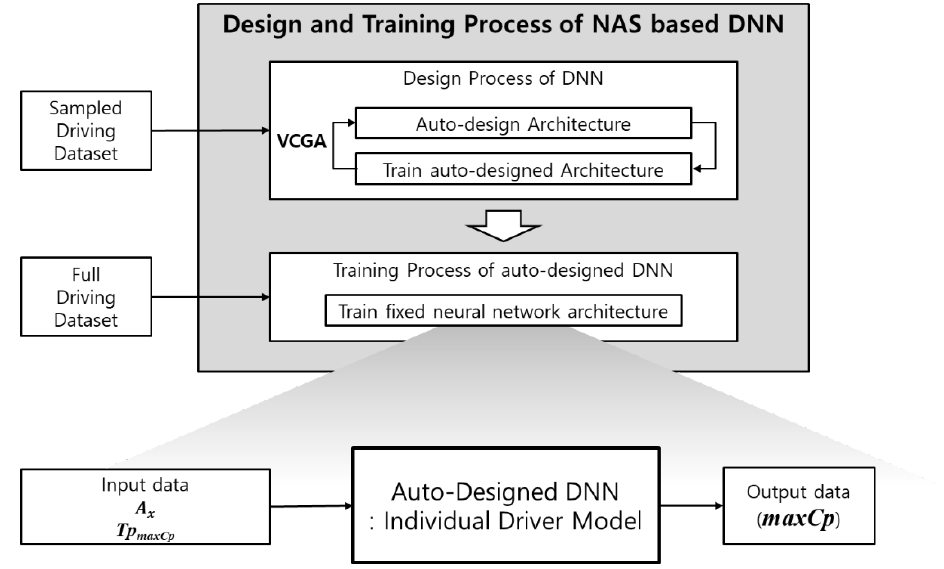
Figure 6. Auto-design process of DNN using NAS.